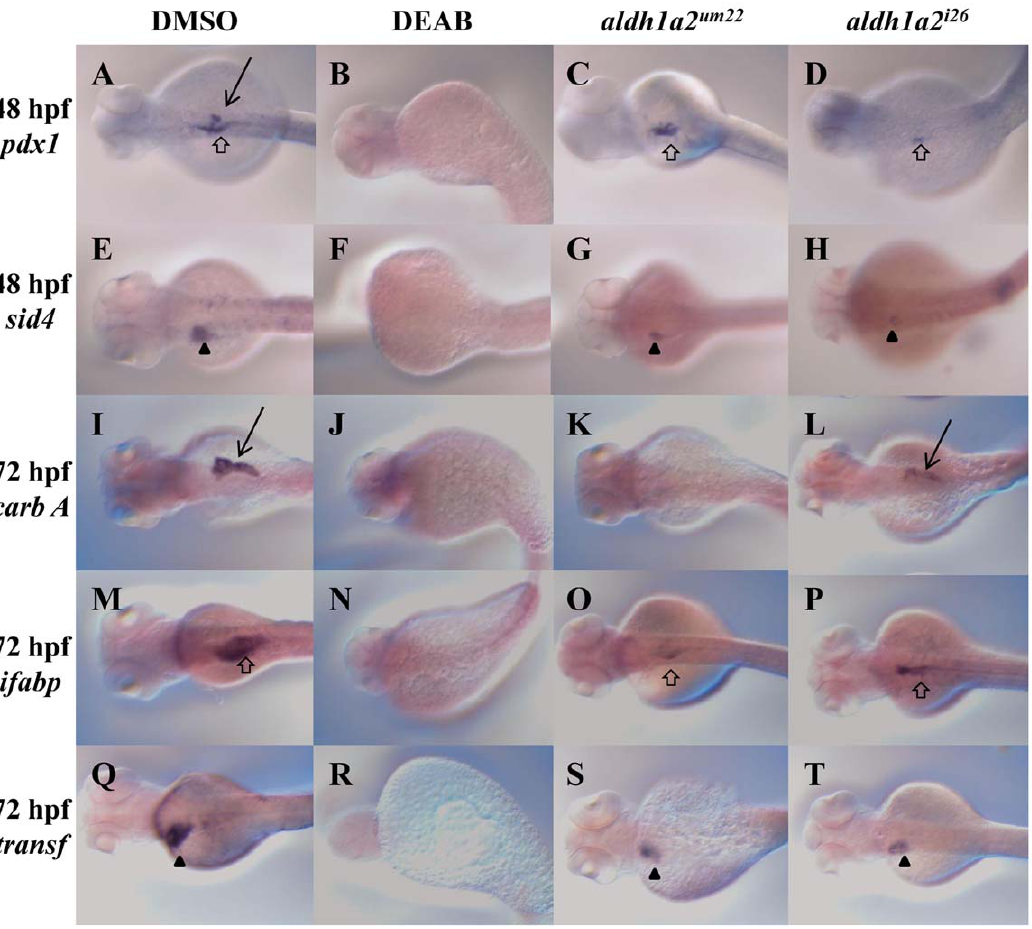
Figure 4. aldh1a2 um22 and aldh1a2 i26 mutant embryos retain some endoderm gene expression at 48 and 72 hpf. DMSO treated wild type embryos (A, E, I, M, Q), DEAB-treated wild type embryos (B, F, J, N, R), embryos from an incross of aldh1a2 um22 heterozygotes (C, G, K, O, S) and embryos from an incross of aldh1a2 i26 heterozygotes (D, H, L, P, T) were assayed for expression of pdx1 at 48 hpf (A–D), sid4 at 48 hpf (E–H), carbA at 72 hpf (I–L), ifabp at 72 hpf (M–P) and transf at 72 hpf (Q–T). Gene expression is observed in the intestine (open arrows), liver (black arrowheads) and pancreas (black arrows). Embryos are in dorsal view with anterior to the left. See Table 2 for quantification.